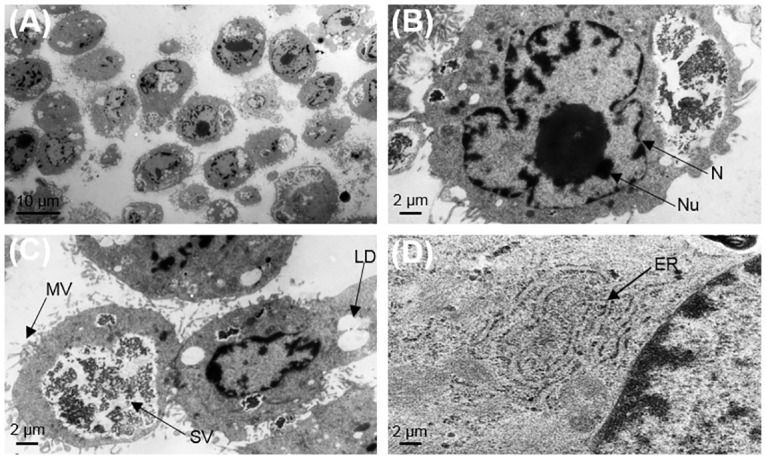
Ultrastructural characteristics of the GEE cell line using TEM.(A and B) Morphology of the cell line was cuboidal and nucleus (N) was large and irregular containing a large prominent nucleolus (Nu). (C and D) Cell surface was covered by abundant microvilli (MV) of irregular shape. Cytoplasm had a significant quantity of secretory vesicles (SV), lipid droplets (LD) and endoplasmic reticulum (ER).